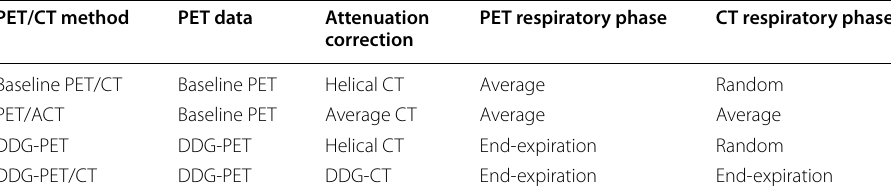
Table 1 Summary of PET/CT methods used in this